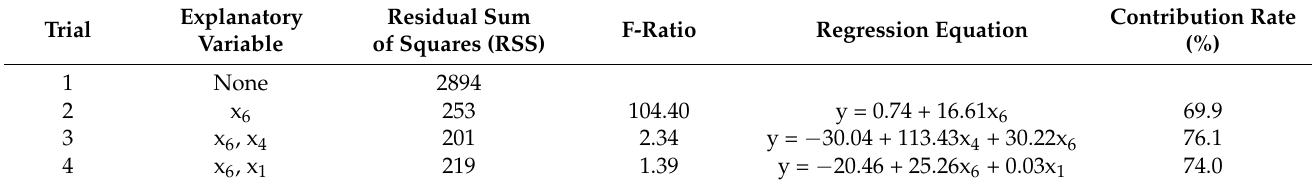
Table 6. Multiple regression analysis